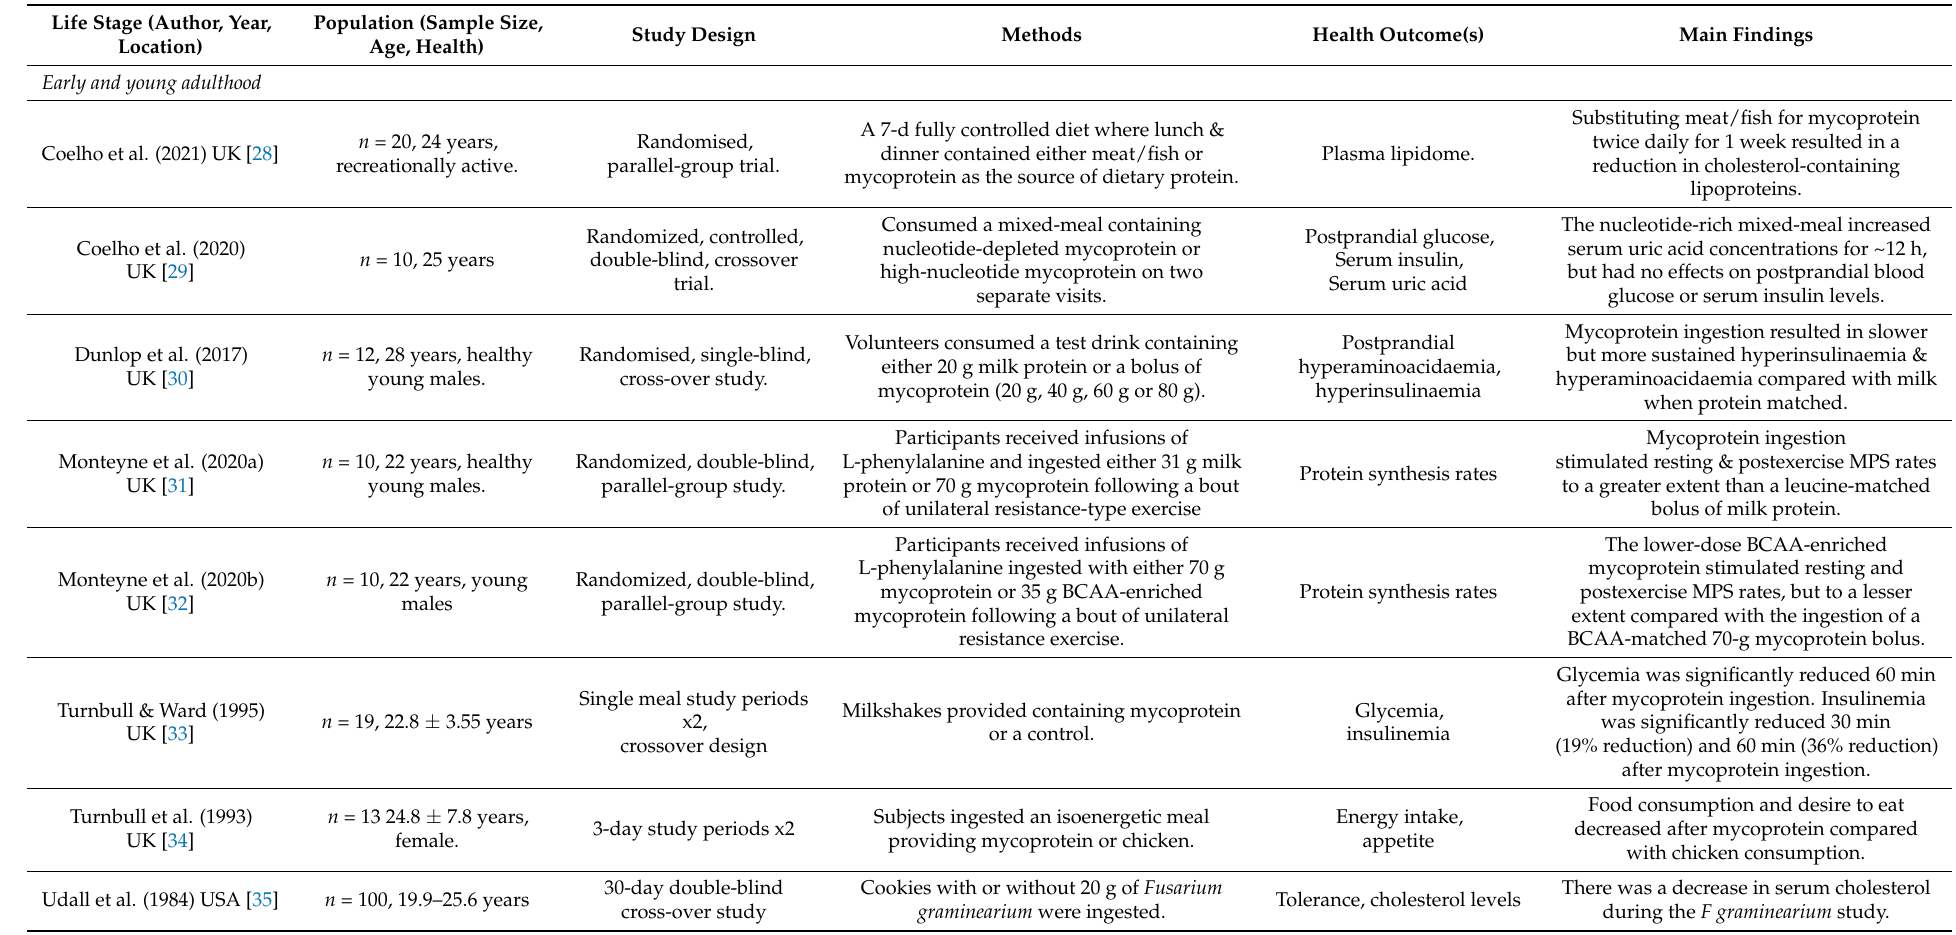
Table 1. Mycoprotein & Health Across the Lifespan: Key